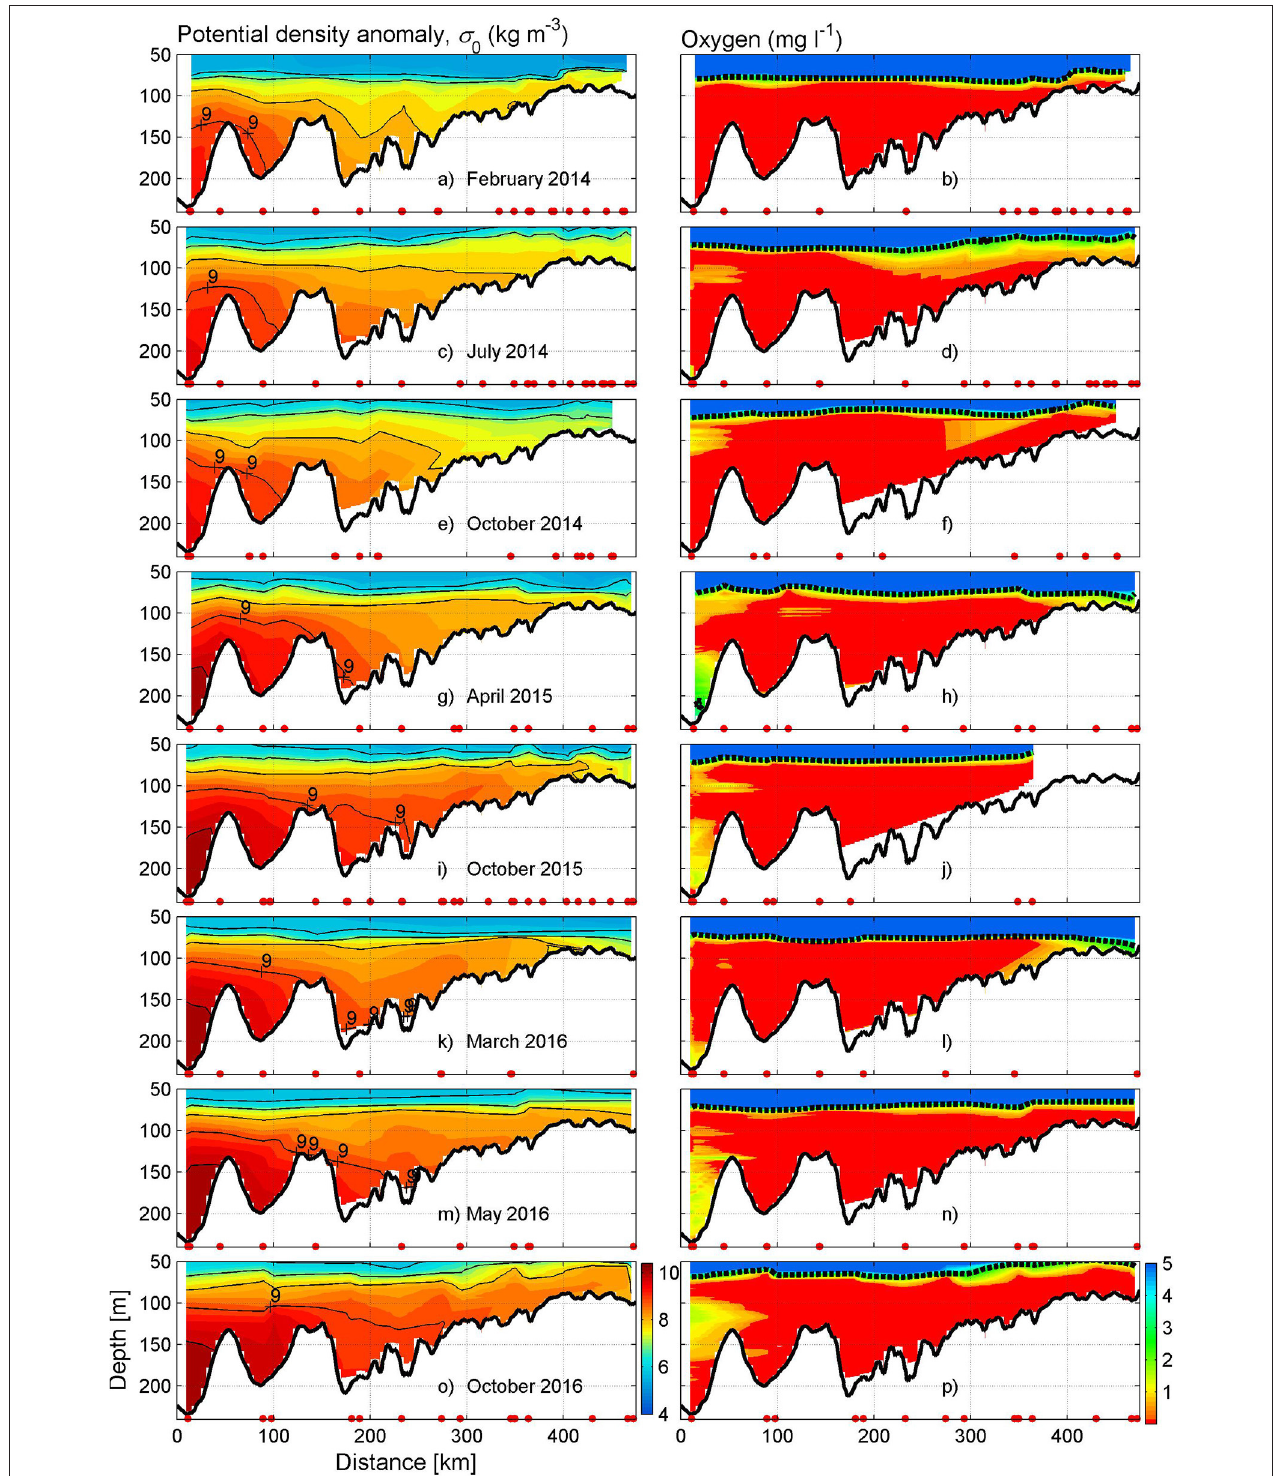
FIGURE 3 | Vertical sections of monthly mean density and oxygen along the pathway from the Gotland Deep to the Gulf of Finland (see Figure 1A ) in February 2014 (a, b) , July 2014 (c,d) , October 2014 (e, f) , April 2015 (g, h) , October 2015 (i, j) , March 2016 (k, l) , May 2016 (m, n) , October 2016 (o, p) . Red dots on x-axis represent the locations of the CTD stations used. Black solid isolines are shown on density plots by 1kg m − 3 step. Black dashed line (right panels) marks the dissolved oxygen concentration of 2.9mg l − 1 (threshold concentration for hypoxia).